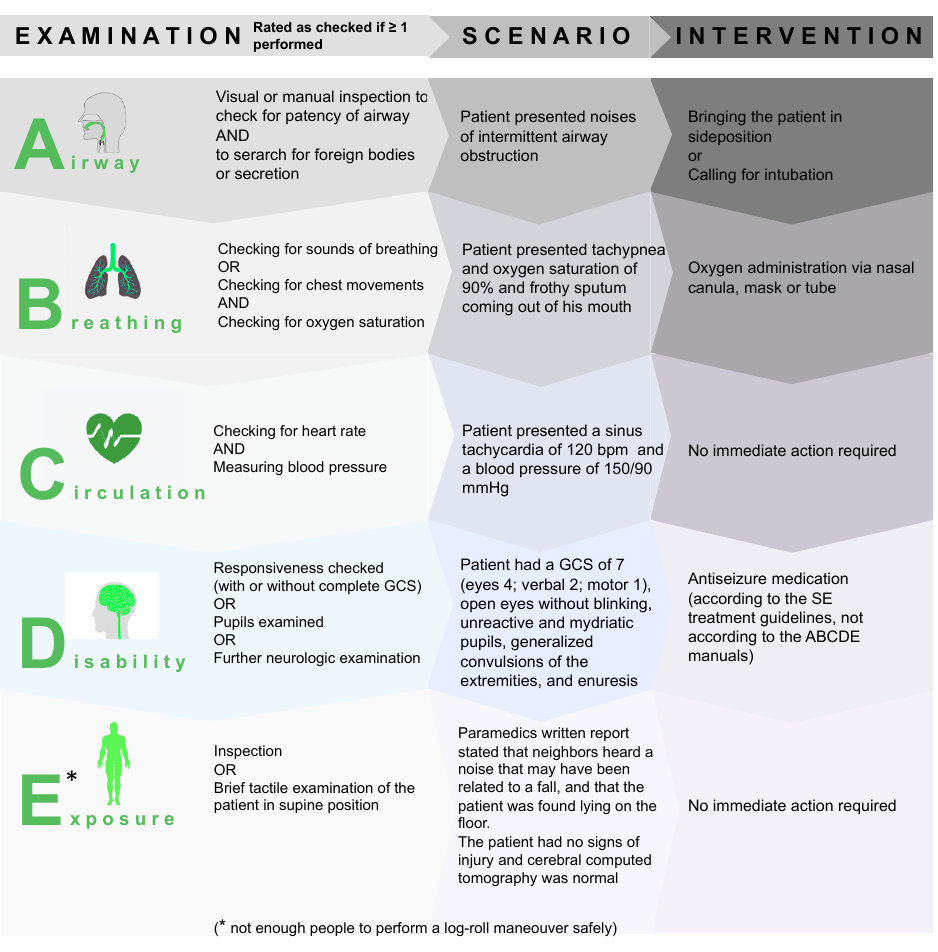
Figure 1. Details of the clinical scenario, the ABCDE examinations, and the measures which should have been taken in response of the clinical findings. GCS = Glasgow Coma Scale.